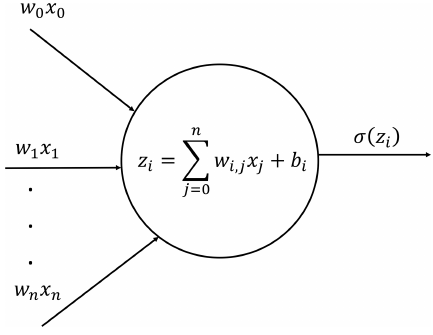
Figure 1. Schematic representation of an artificial